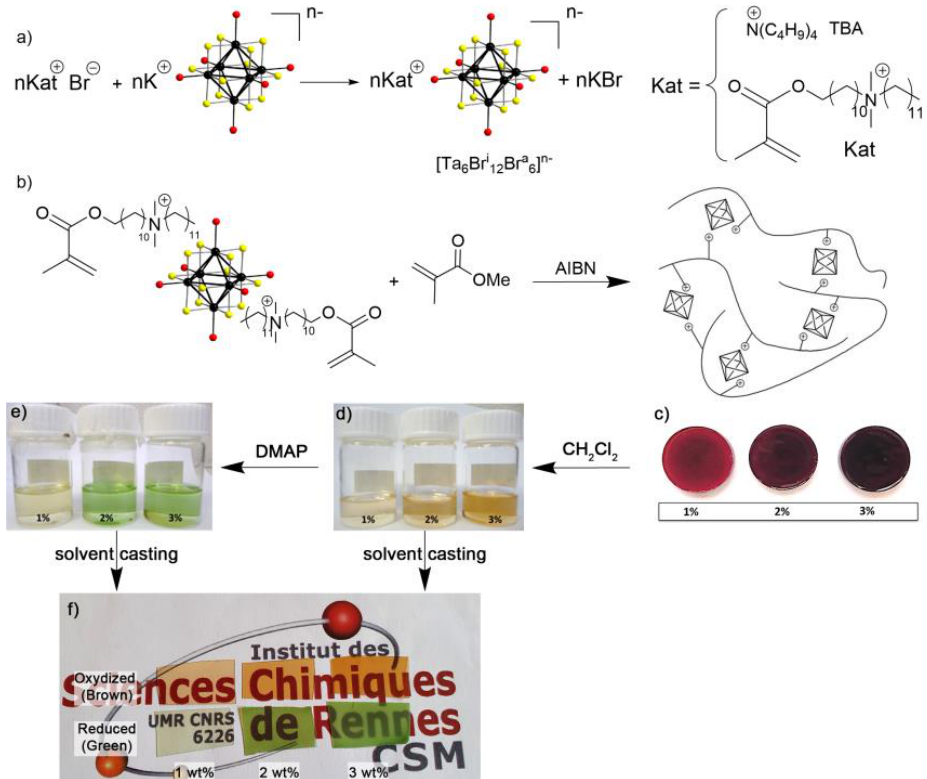
Figure 2. ( a ) Representation of the cationic metathesis reaction between organic ammonium cations (Kat) and potassium in K 4 [{Ta 6 Br i 12 }Br a 6 ], ( b ) Representation of the bulk radical polymerization reaction with MMA carried out at 60 °C for 24 h, ( c ) the brown pellets obtained, ( d ) Solution of brown pellets in CH 2 Cl 2 , ( e ) Reduction in brown Ta 6 cluster units in solution with two equivalents of DMAP and ( f ) Pictures of brown and green films obtained by solvent casting.